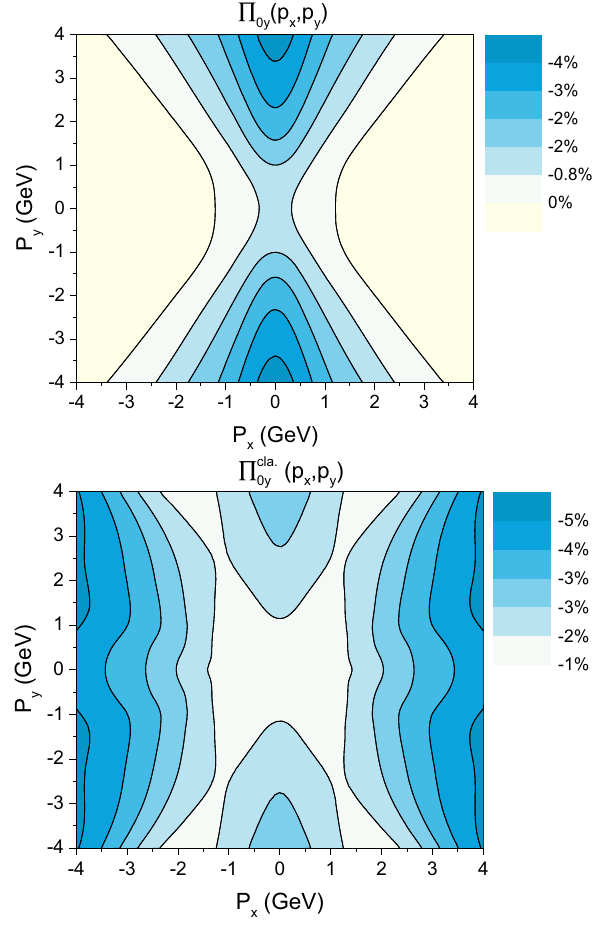
Fig. 2 The y component of total polarization in the Λ ’s rest frame (upper panel), and of the polarization when only considering the clas- sical vorticity term (lower panel), for Au + Au 200 GeV collisions with impact parameter ratio b 0 = 0 . 6 at the rapidity bin | y | < 1